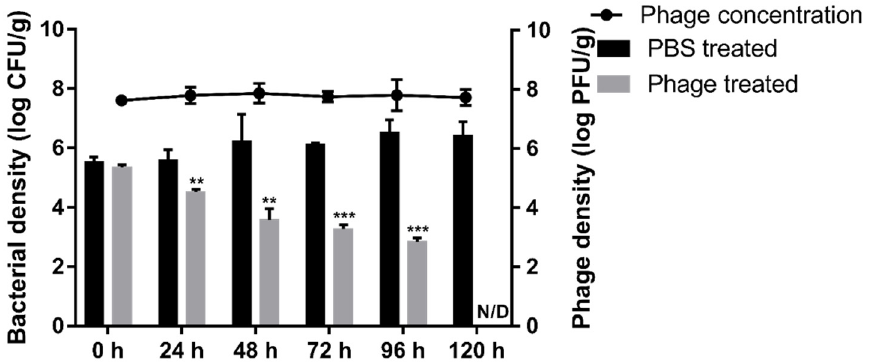
Figure 7. Food application of phage BECP10. The biocontrol effect of BECP10 against E. coli O157:H7 contaminated burger patties was evaluated. Line and bar graphs represent the viability of phage and E. coli O157:H7 cells on patties, respectively. The dotted line represents the limit of detection for the viable cell count. All experiments were independently performed in triplicate, and the results are presented as mean ± SD. Asterisks indicate statistical significance (** p < 0.01, *** p < 0.001). N/D: not detected.